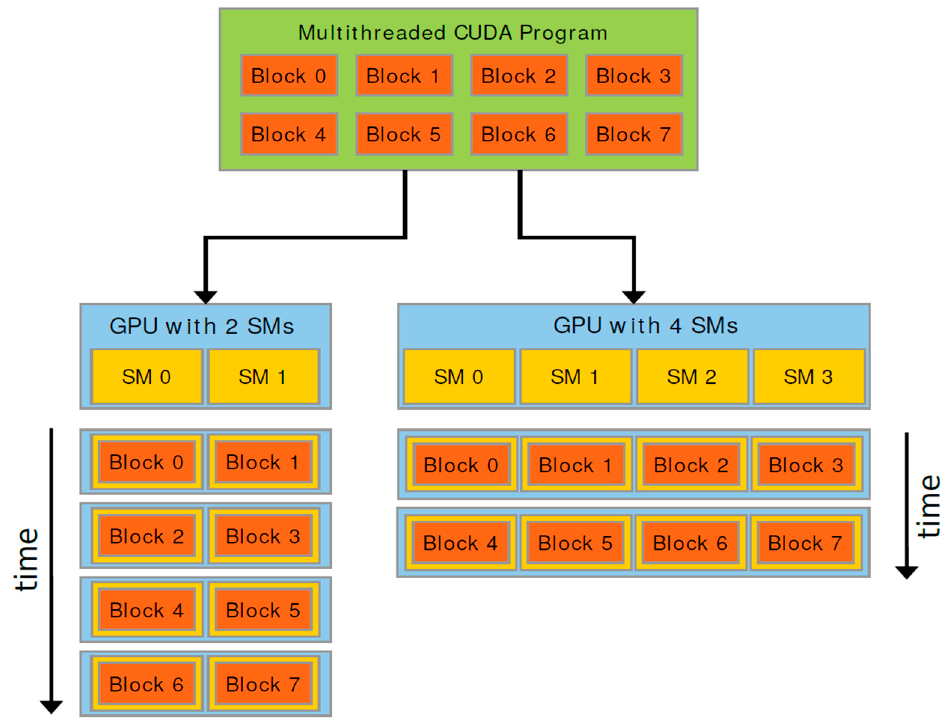
Figure 4. Schematic overview of a GPU Figure 4 . Schematic overview of a GPU program.